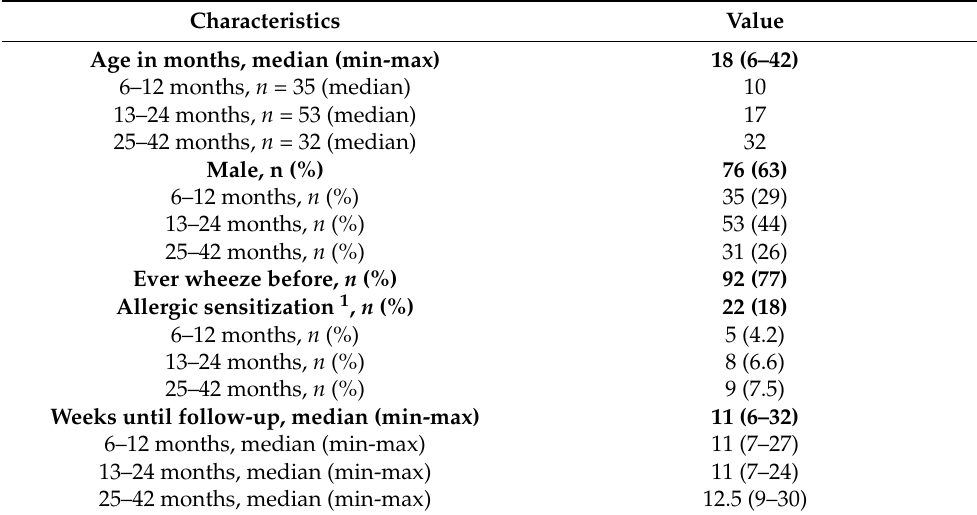
Table 1. Characterization of the analyzed wheezing children.